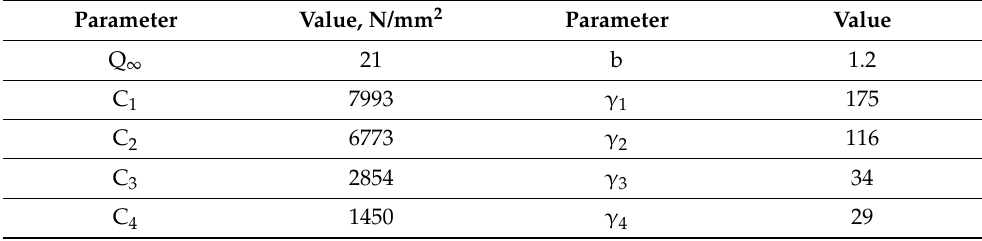
Table 2. Hardening parameters of materials (ABAQUS).